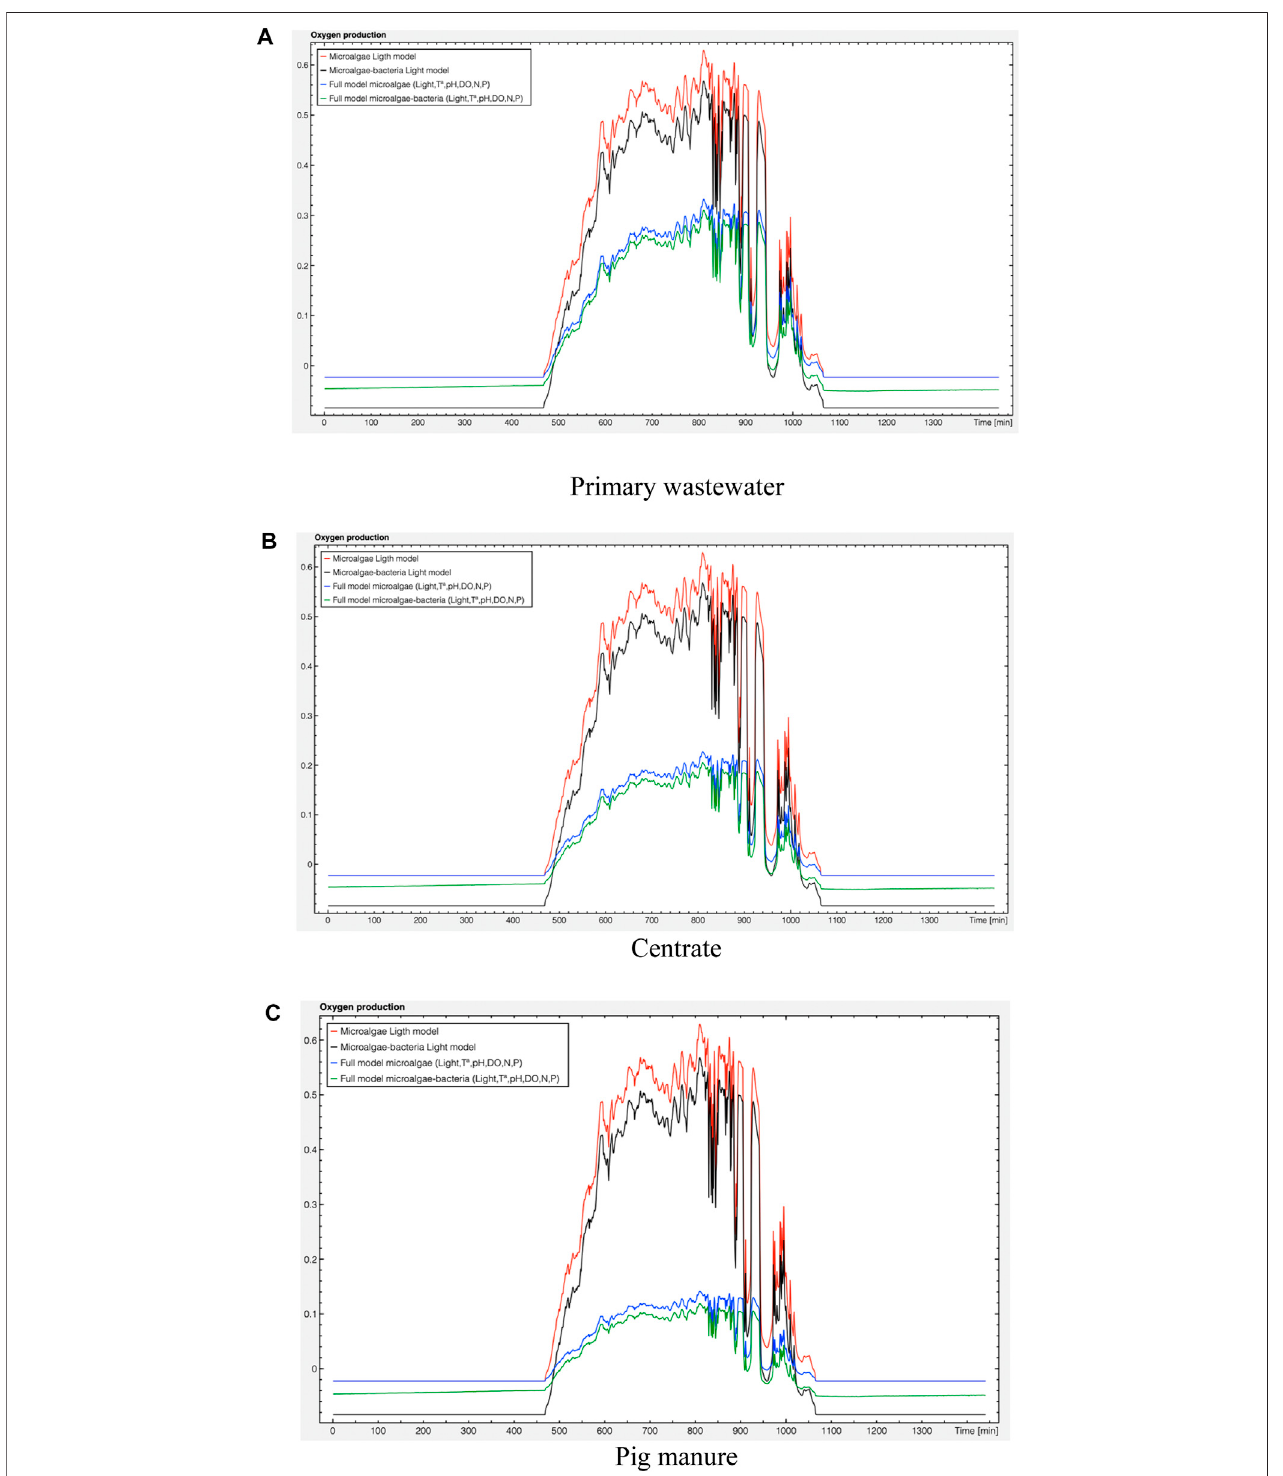
FIGURE7| Applicationofthebiologicalmodelstopredicttheproductivityofthemicroalgalbasedsystemusingdifferenttypesofwastewater: (A) wastewaterfrom primary treatment; (B) centrate from anaerobic digestion; (C) Pig manure.